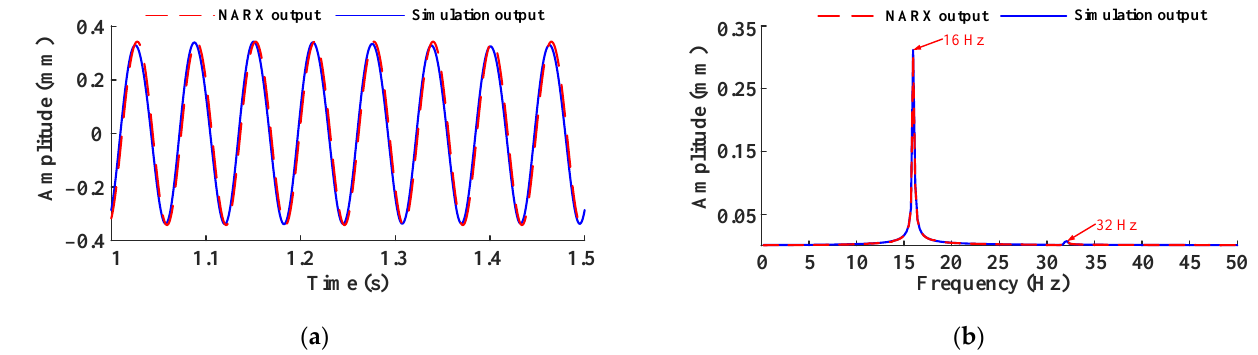
=100.5 rad/s ω =100.5 rad/s ω